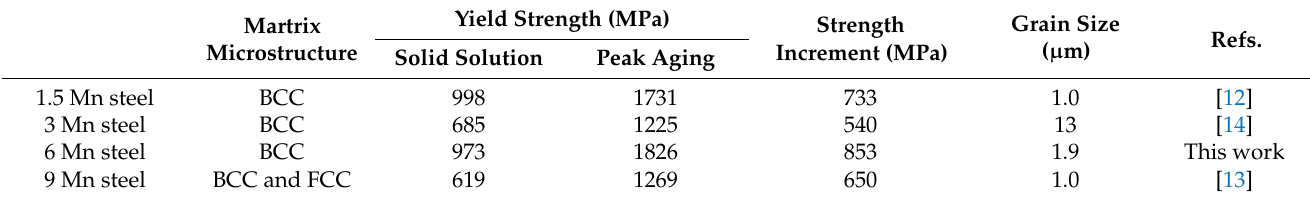
Grain Size Refs. ( µ m) Increment (MPa)